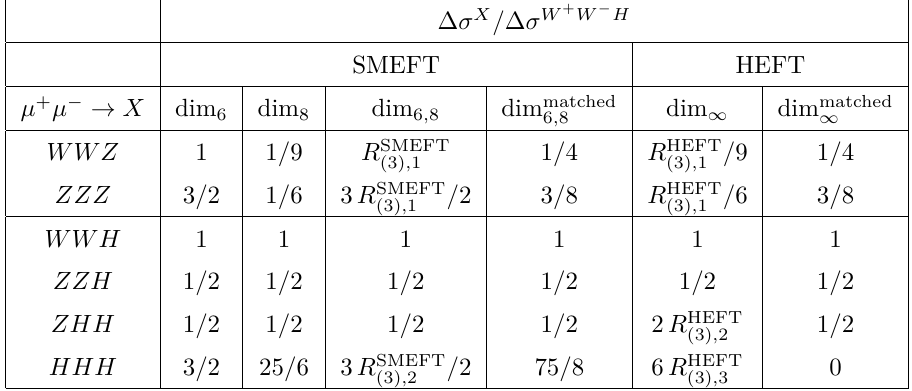
Table 2 . Same as table 1 but for triboson production. The coefficients R in